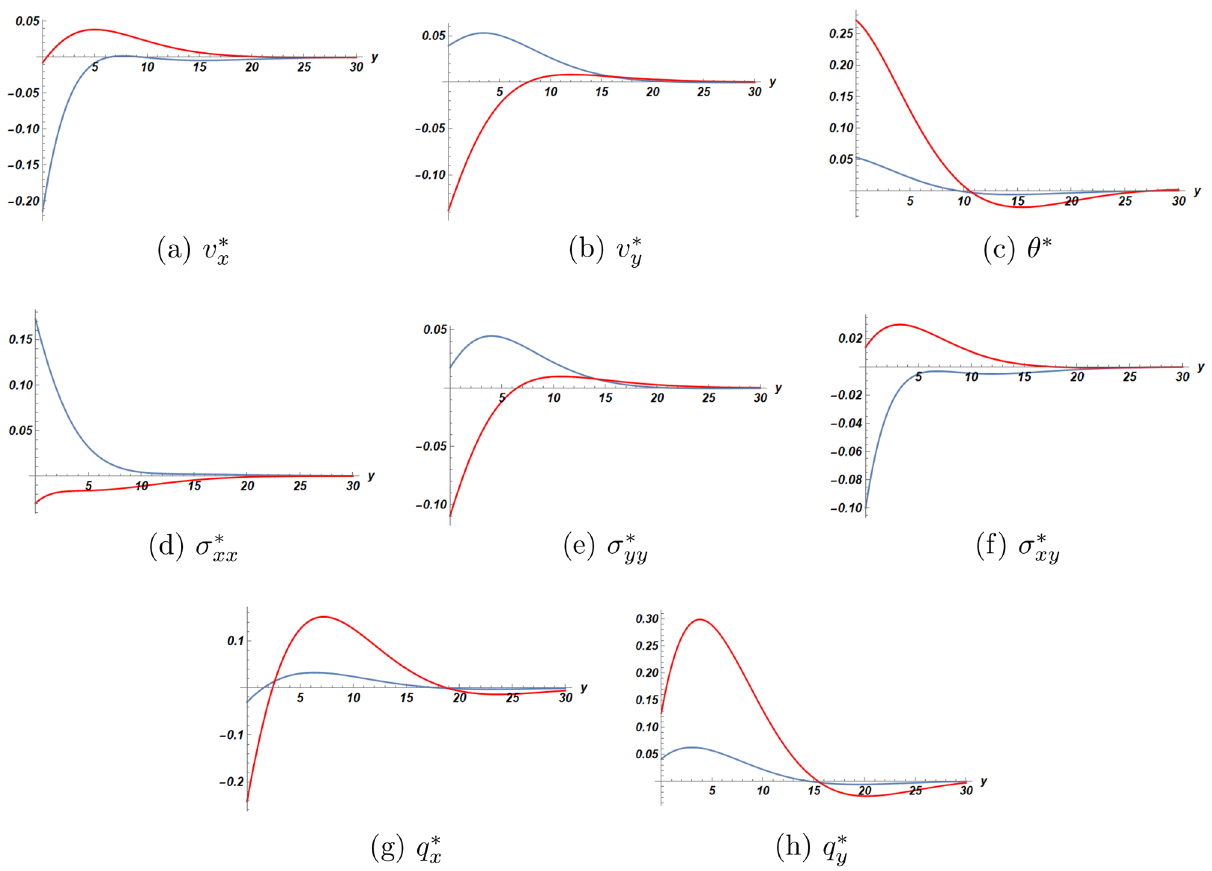
Figure 4. Comparison of first order solutions as functions of y at x = 2 , t = 2.1 (red dot) half-space (blue dot) half-space with